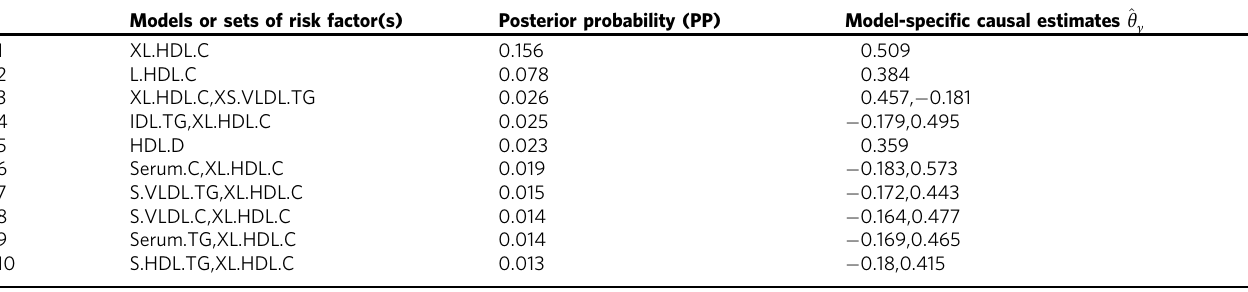
Table 3 Ranking of models (sets of risk factors) for age-related macular degeneration (AMD) according to their posterior probability (PP) after exclusion of outlying and in fl uential variants ( n ¼ 145).